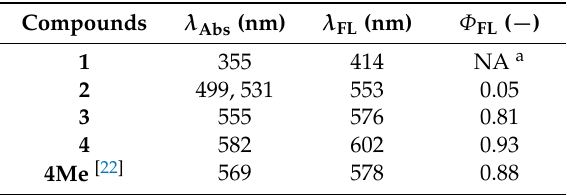
Table 1. Photophysical parameters for 1 – 4 and 4Me .